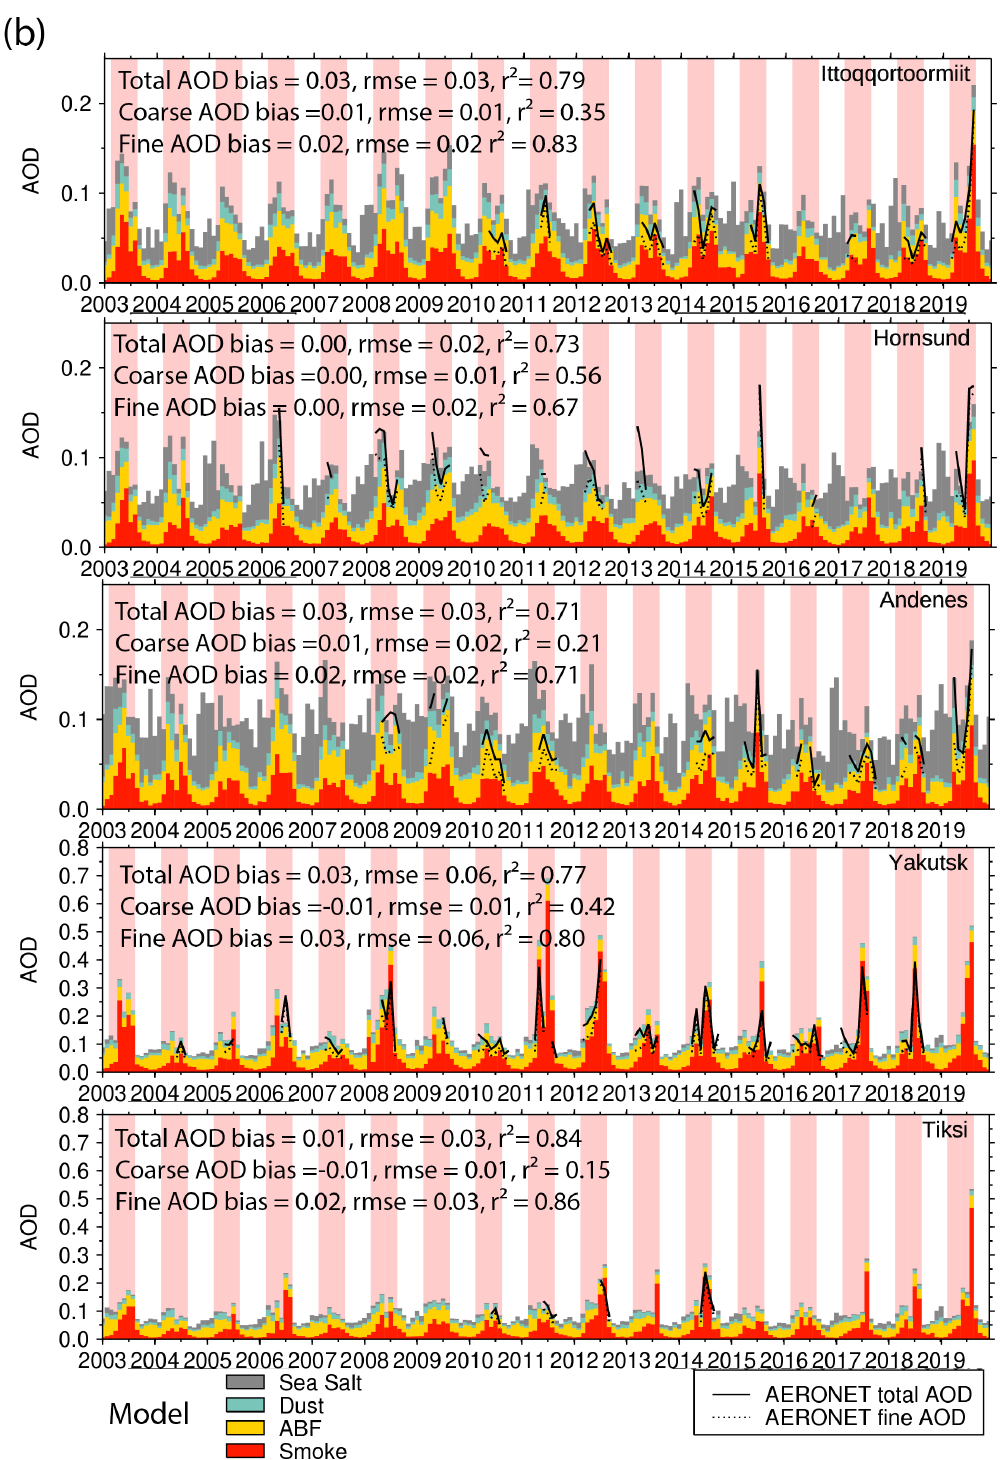
Figure 2. Monthly binned time series of FM, CM, and total AERONET AODs and MRC speciated AOD at (a) Bonanza Creek, Barrow, Resolute_Bay, Thule, and Kangerlussuaq and (b) Ittoqqortoormiit, Hornsund, Andenes, Yakutsk, and Tiksi sites. The March–August periods are highlighted with pink shading for easy reading. The legends of each time series show MRC bias, RMSE, and r 2 .